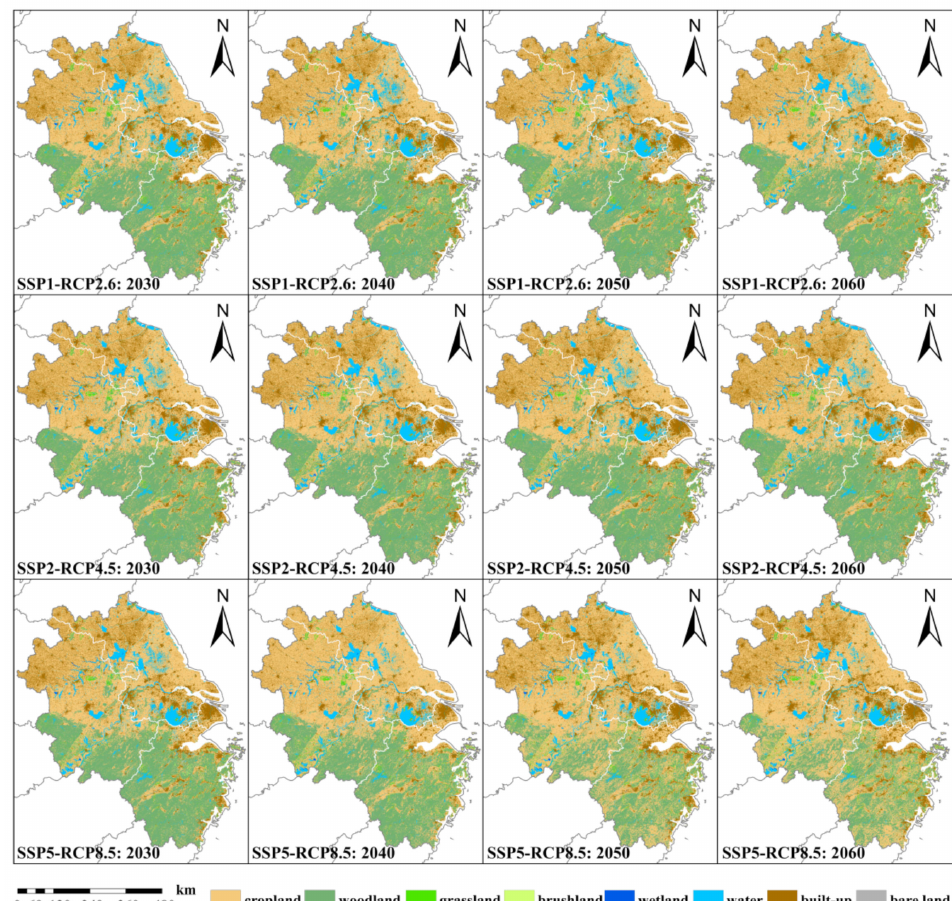
Figure 9. Simulation of land use patterns under different scenarios of 2030, 2040, 2050,